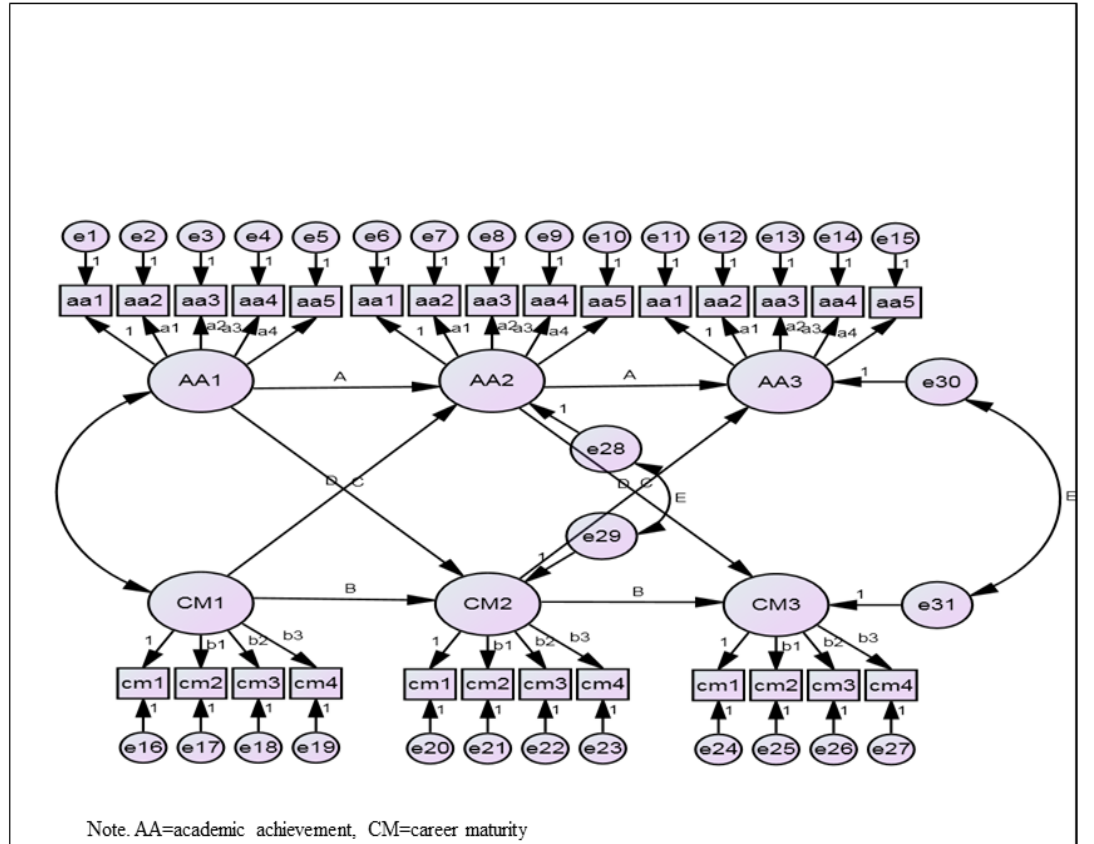
Figure 1. Autoregressive and cross-lagged Figure 1. A utoregressive and cross-lagged model .